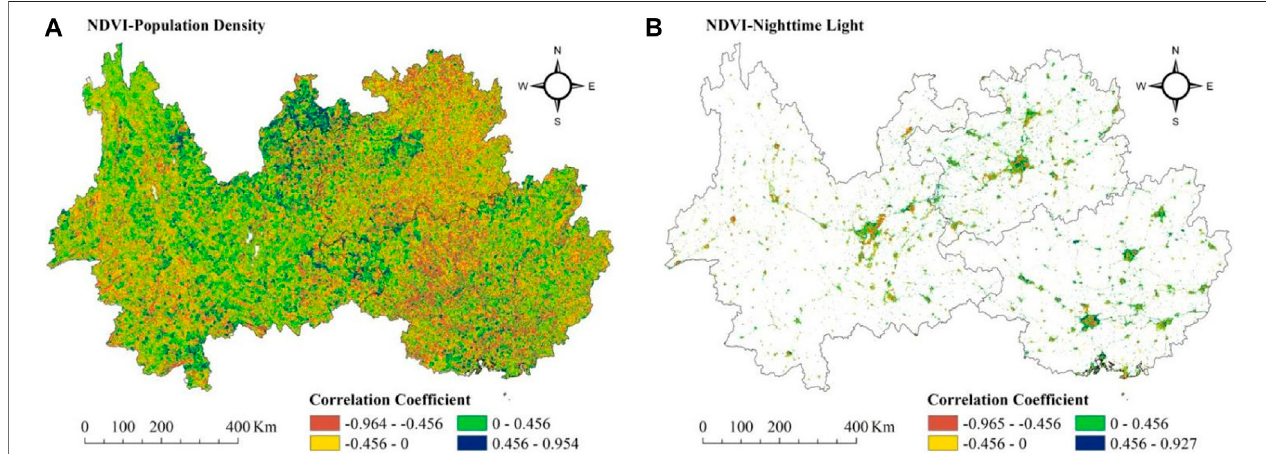
FIGURE 11 | The correlation among NDVI and PD, NTL in the three karst provinces of southwest China.